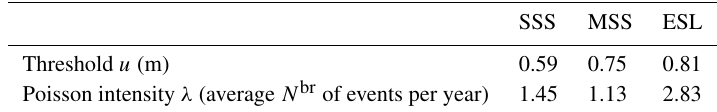
Table 2. POT thresholds for SSS, MSS and ESL variables.